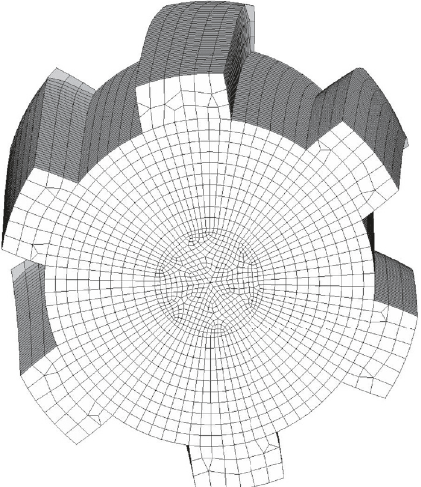
Figure 9: Deformed shape of the straight-teeth spline shaft (lead angle 𝛽 = 90 deg) under torque local case (magnification factor = 800).